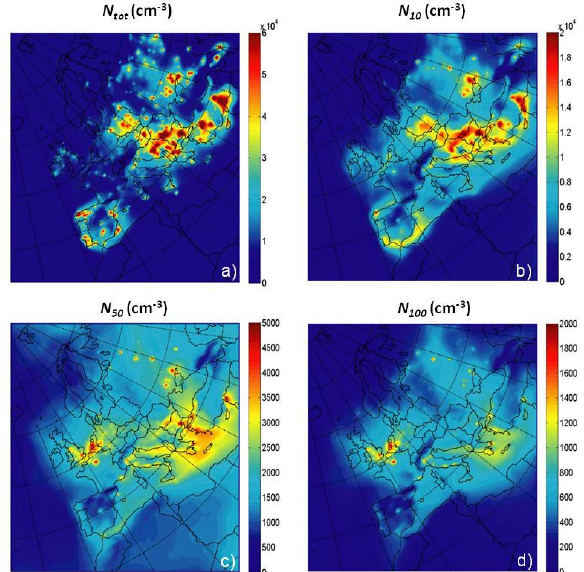
Fig. 2. Ground level average fractional increase of number concen- tration due to nucleation predicted during May 2008 for (a) all par- Figure 2. Ground level average fractional increase of number concentration due to ) , particles above (b) 10nm ( f N ) , (c) 50nm ( f N ) ticles ( f N nucleation predicted during May 2008 for (a) all particles ( f (cid:1)tot ), particles above (b) 10 tot 10 50 ) . Different scales are and (d) 100nm ( f N 100 nm ( f (cid:1)10 ), (c) 50 nm ( f (cid:1)50 ) and (d) 100 nm ( f (cid:1)100 ). Different scales are used.